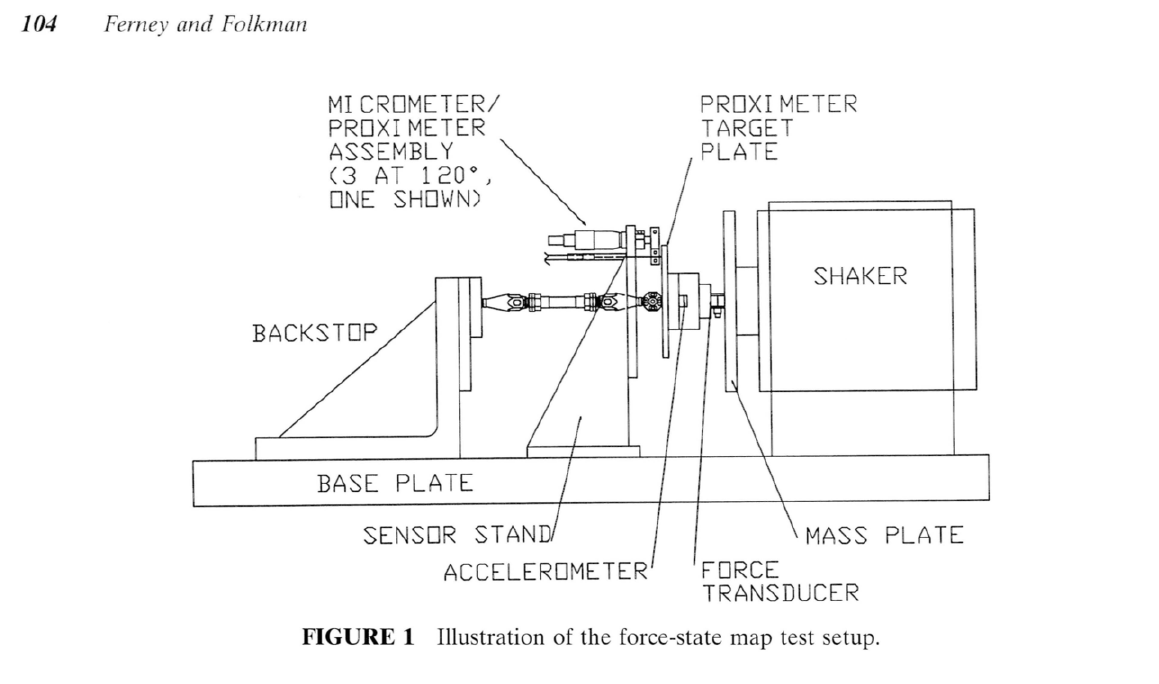
FIGURE 1 Illustration of the force-state map test setup.